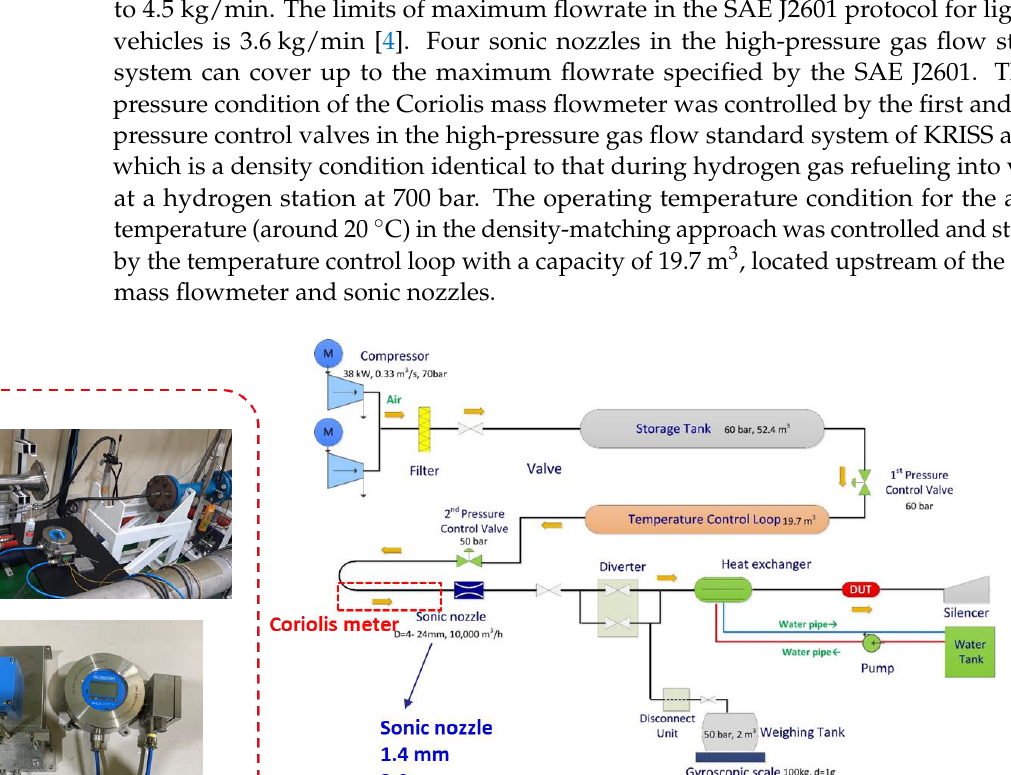
Figure 3. High-Pressure Gas Flow Standard System of KRISS.